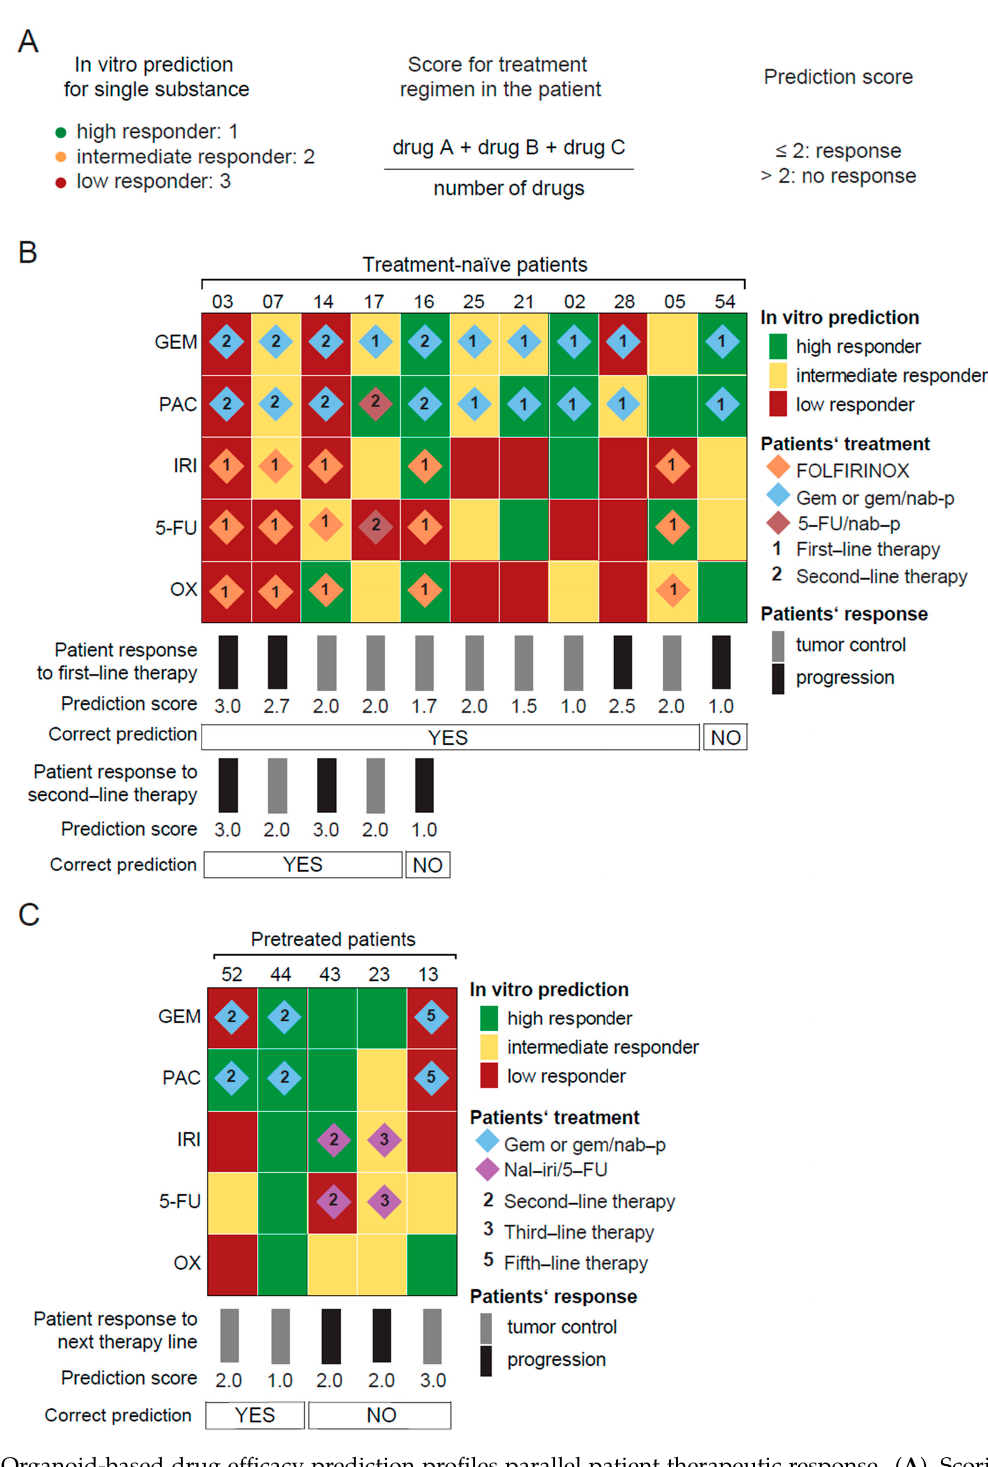
Figure 3. Organoid-based drug efficacy prediction profiles parallel patient therapeutic response. ( A ), Scoring method to predict the patient therapeutic response of a given combinational regimen based on the in vitro prediction for single substances. PDO-based drug response prediction in ( B ), treatment-naïve and ( C ), pretreated PDO samples according to the prediction score shown in ( A ). For each single chemotherapeutic substance, the clustering of the PDO library into high, intermediate, and low responder subgroups was performed using the Jenks Natural Breaks classification method, as shown in Figure 2. Patients’ treatment regimen, therapy line, and therapeutic response as indicated. 5-FU,